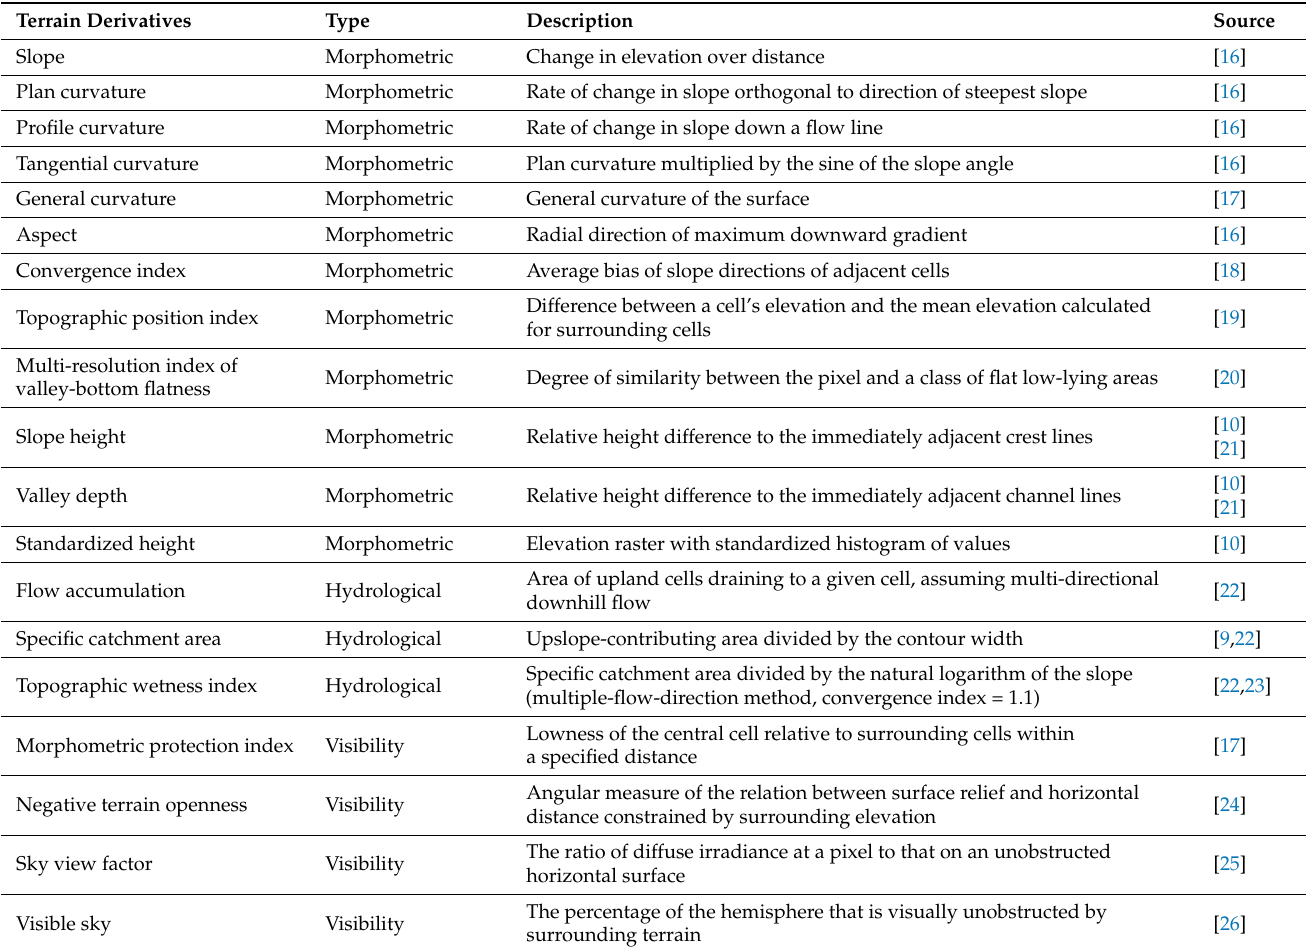
Table 1. The terrain derivatives calculated from the digital elevation model and used to classify the